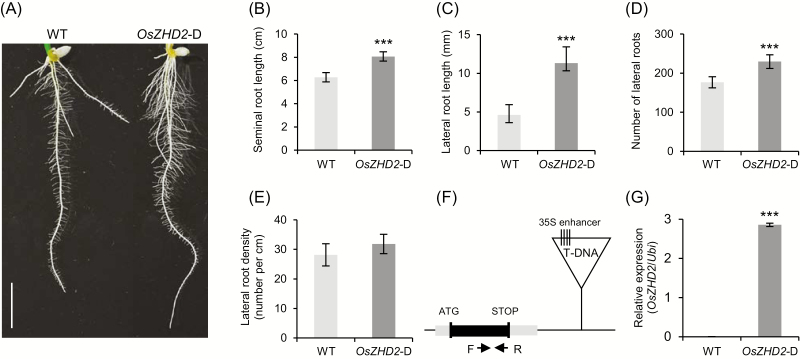
Characterization of OsZHD2-D. (A) Root phenotypes at 8 DAG. Scale bar=1 cm. (B) Seminal root lengths of seedlings at 8 DAG that were grown under hydroponic culture conditions. n=13. (C) Lateral root lengths at the top 1 cm regions of seminal roots at 8 DAG. n>40. (D) Number of lateral roots at 8 DAG. n=7. (E) Density of lateral roots at the top 1 cm regions of seminal roots. n=7. Error bars show the SD. Statistical significance is indicated by *** (P<0.001). (F) Schematic diagram of the OsZHD2 genome and T-DNA insertion position in Line 3A-13017. T-DNA was inserted 5 kb downstream from the stop codon. (G) Transcript levels of OsZHD2 in the WT and the OsZHD2-D activation line. RNA samples were collected from leaf blades at the seedling stage. qRT-PCR was performed to measure the transcript levels using the gene-specific primers indicated by arrows in (F). n=4. Error bars show the SD. Statistical significance is indicated by *** (P<0.001).